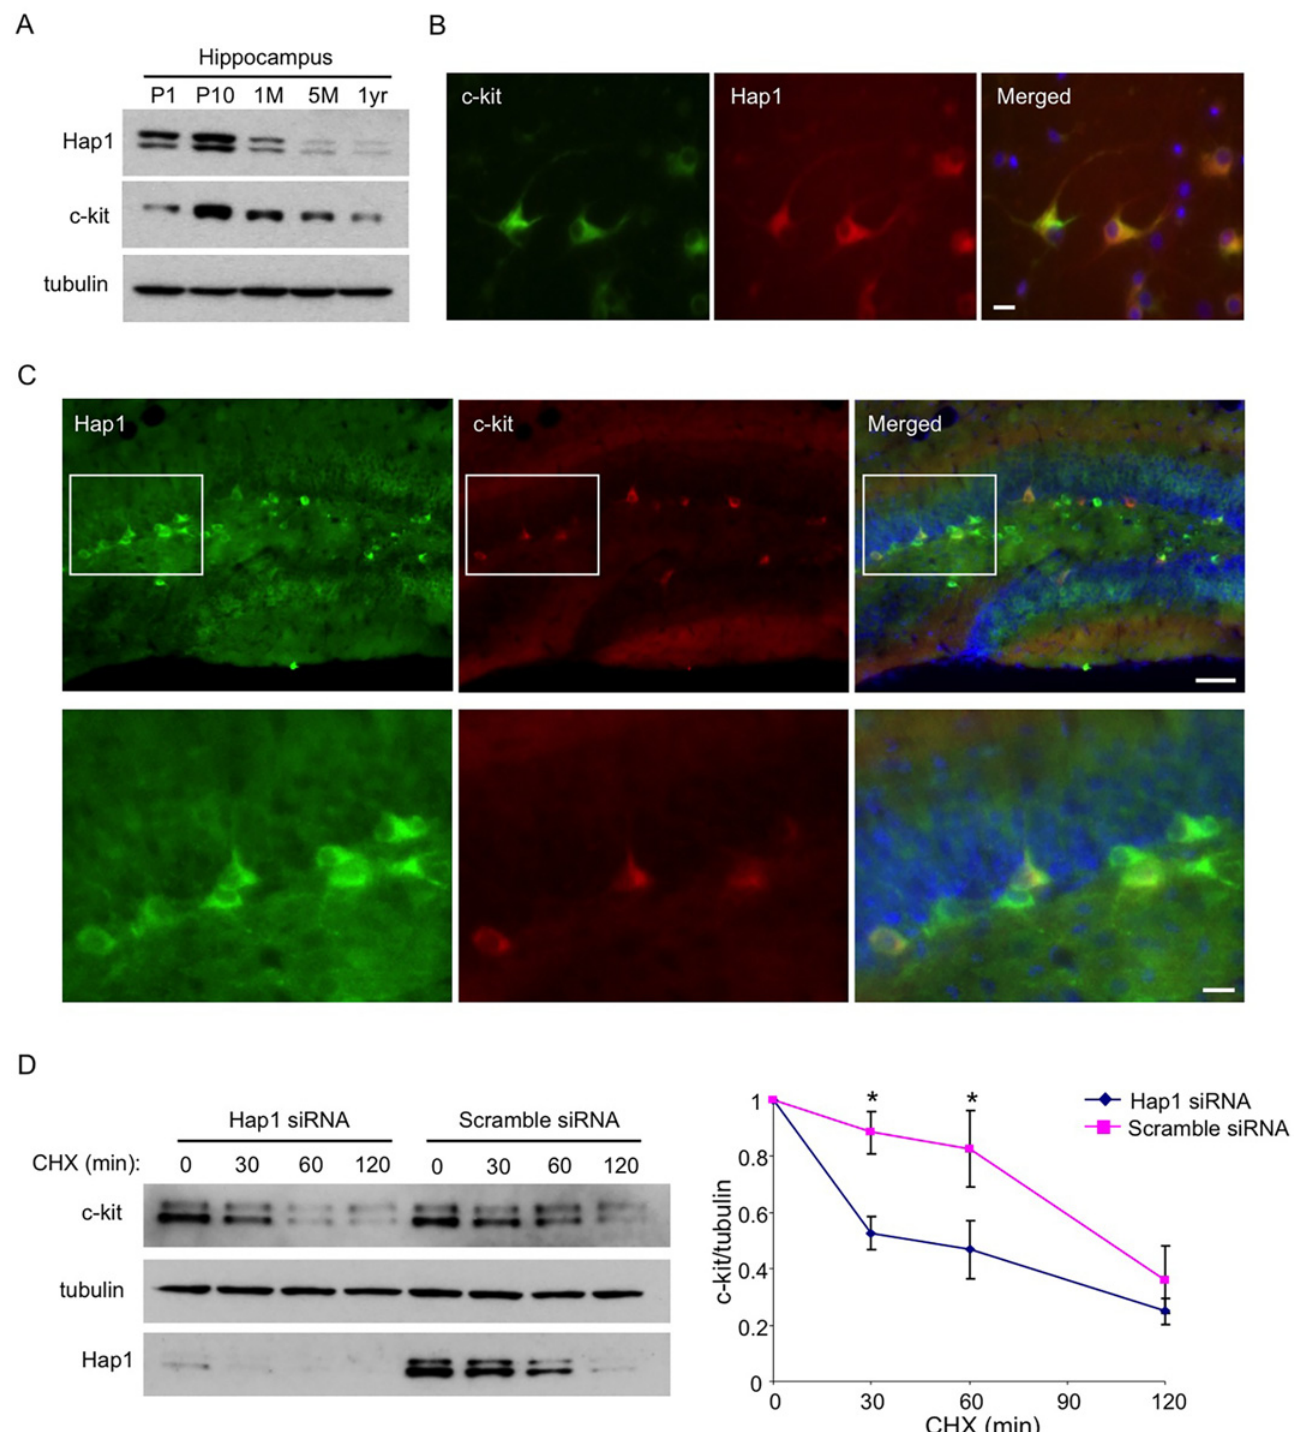
Fig 6. Hap1 is coexpressed with c-kit and stabilizes its level in vitro. ( A ) Age-dependent expression levels of Hap1 and c-kit in the hippocampus of mice at different ages. Both proteins peak in their expression at the postnatal stage. ( B ) Hippocampal neuronal culture at DIV5 was immunostained with antibodies against Hap1 and c-kit. The two proteins are coexpressed in the majority of cultured hippocampal neurons. Scale bar: 10 μ m. ( C ) Brain sections from P15 WT mouse were immunostained with antibodies to Hap1 and c-kit. Hap1 and c-kit are coexpressed in some neurons in the hippocampal DG. Lower panel represents magnified images of the boxed areas in the upper panel. Scale bars: 40 μ m (upper panel), 10 μ m (lower panel). ( D ) Plasmid construct